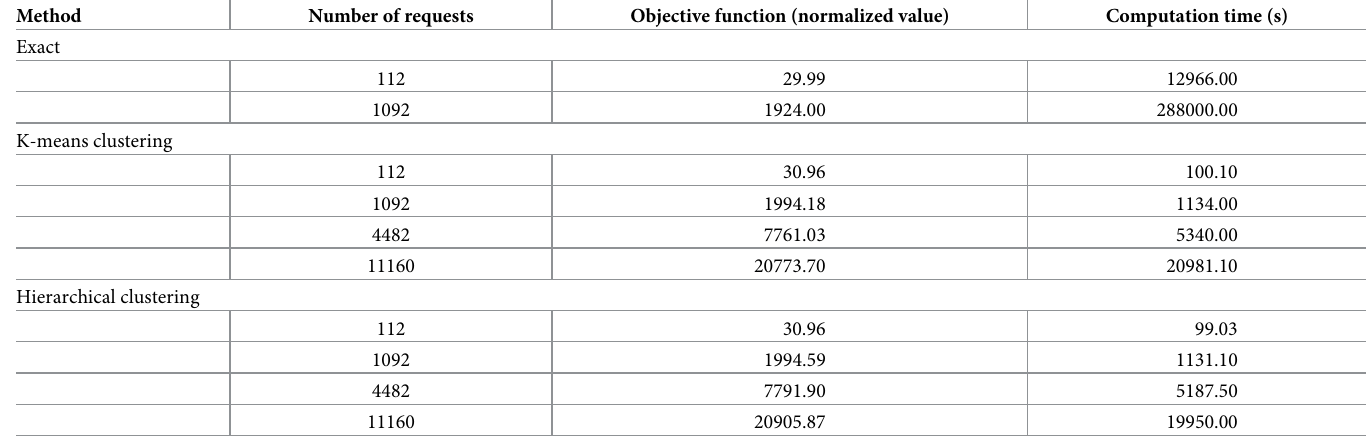
Table 5. Clustering methods